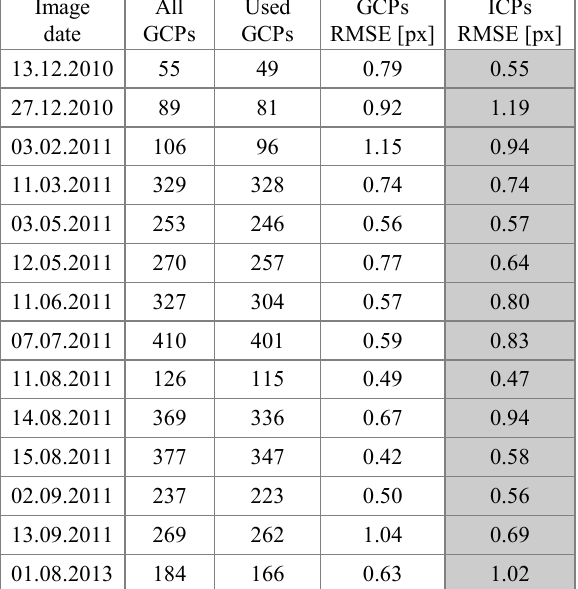
Table 1: RMSE values for fourteen RapidEye level 1B images processed with the physical sensor model. GCPs were reduced by RANSAC and refined by Robust estimation. Independent check points (ICPs) were manually digitized.